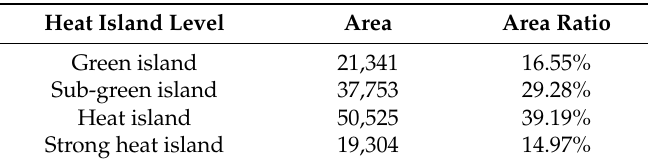
Table 4. Urban heat island level statistical results in Wuhan.